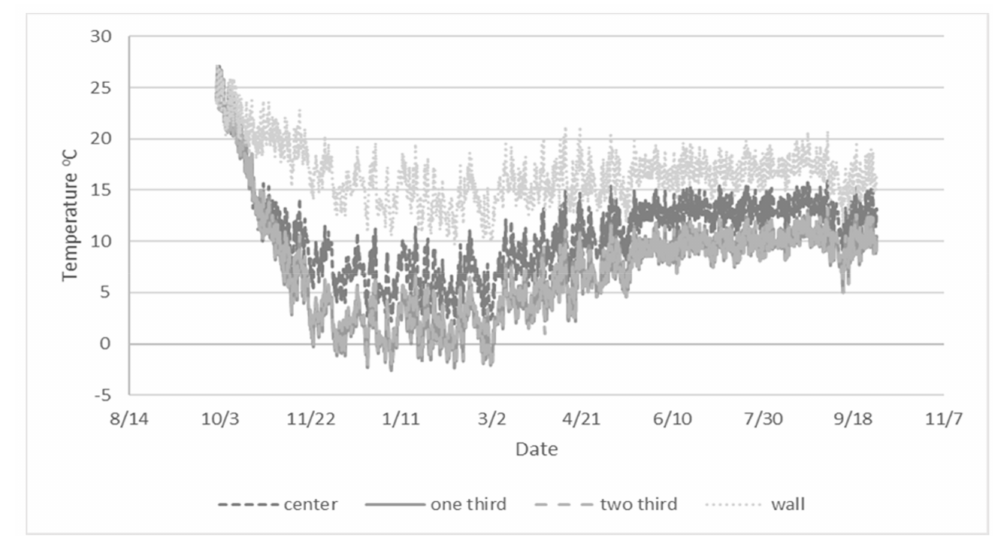
Figure 7. The average temperature of the entire grain mass (all nodes) for one cable configuration defined in Figure 2 as low and placed in the center of the grain mass versus one third and two-thirds distance from the wall, and at the wall, for a one-year controlled aeration simulation of 1346 MT of maize beginning 1 October, 2014. The fan was turned on whenever ambient air was cooler than the average of the sensors, and the average was above 0 ◦